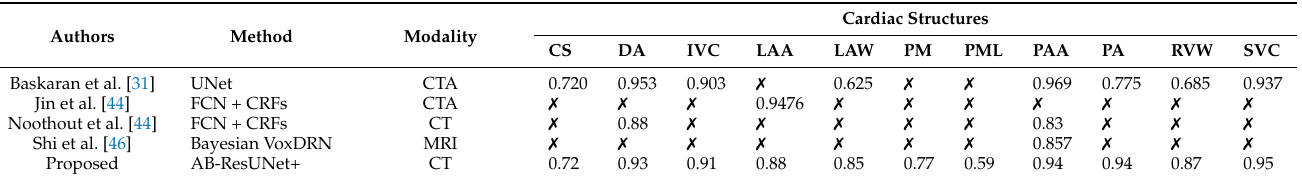
Table 7. Comparison of DSC results obtained with our proposed AB-ResUNet+ architecture and the state-of-the-art segmentation